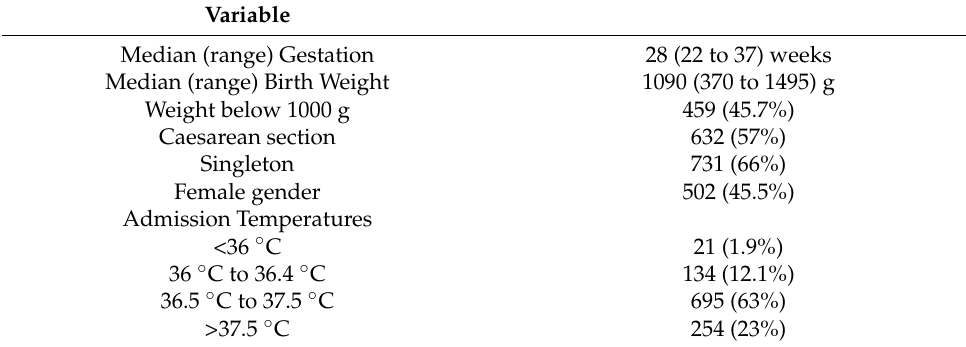
Table 1. Demographics and admission temperatures of study